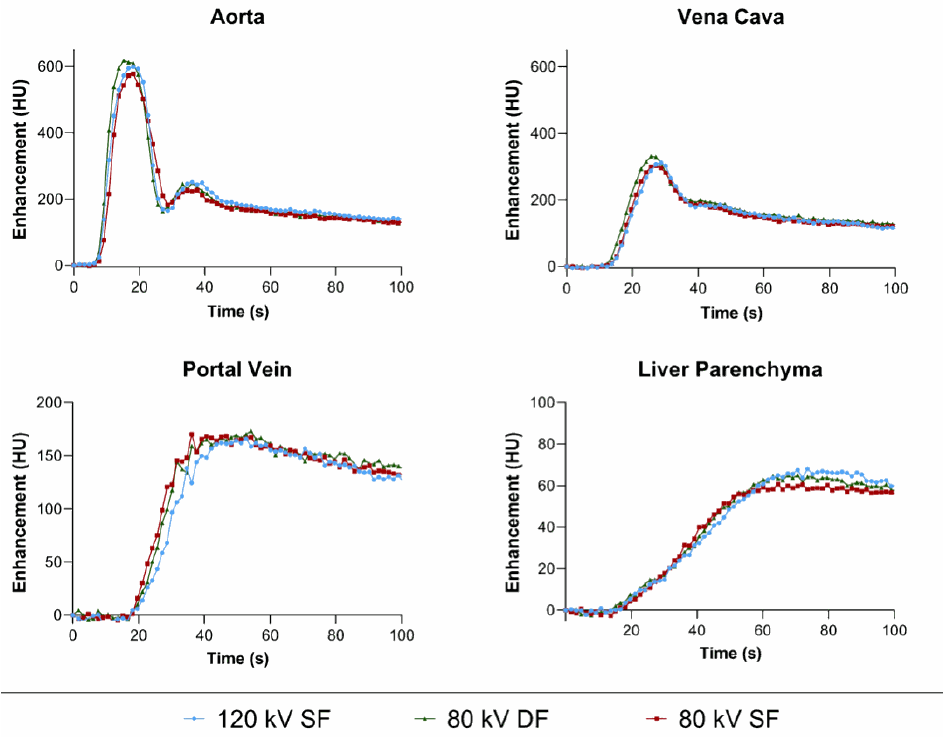
Figure 1. Time attenuation curves for different injection protocols for aorta, vena cava, portal vein, and liver parenchyma. Green curve represents the 80 kV DF protocol; red curve represents the 80 kV SF protocol; blue curve represents the 120 kV SF protocol.